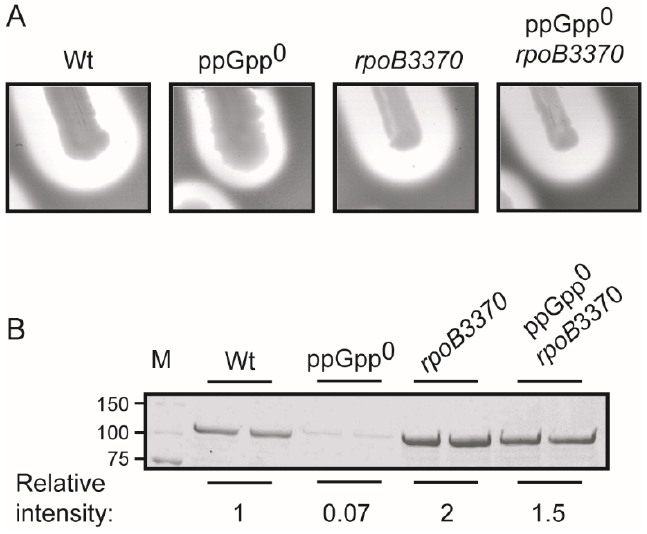
Figure 2. Analysis of the hemolytic phenotype of the ppGpp 0 suppressor mutant rpoB3370 . ( A ) Hemolytic phenotype on blood agar plates of Wt (AAG1), ppGpp 0 (JFV2), rpoB3370 (JFV19), and ppGpp 0 rpoB3370 (JFV20) carrying the plasmid pSF4000. ( B ) Electrophoretic analyses (Coomassie blue stained 10% SDS-PAGE) of the cell-free supernatants from bacterial cultures grown in LB at 37 °C up to late exponential phase (OD 600nm of 0.8) of the same strains as in ( A ). Relative intensities of the protein bands are indicated at the bottom of the panel. Lane M: molecular mass markers (size in kDa indicated along the left side).